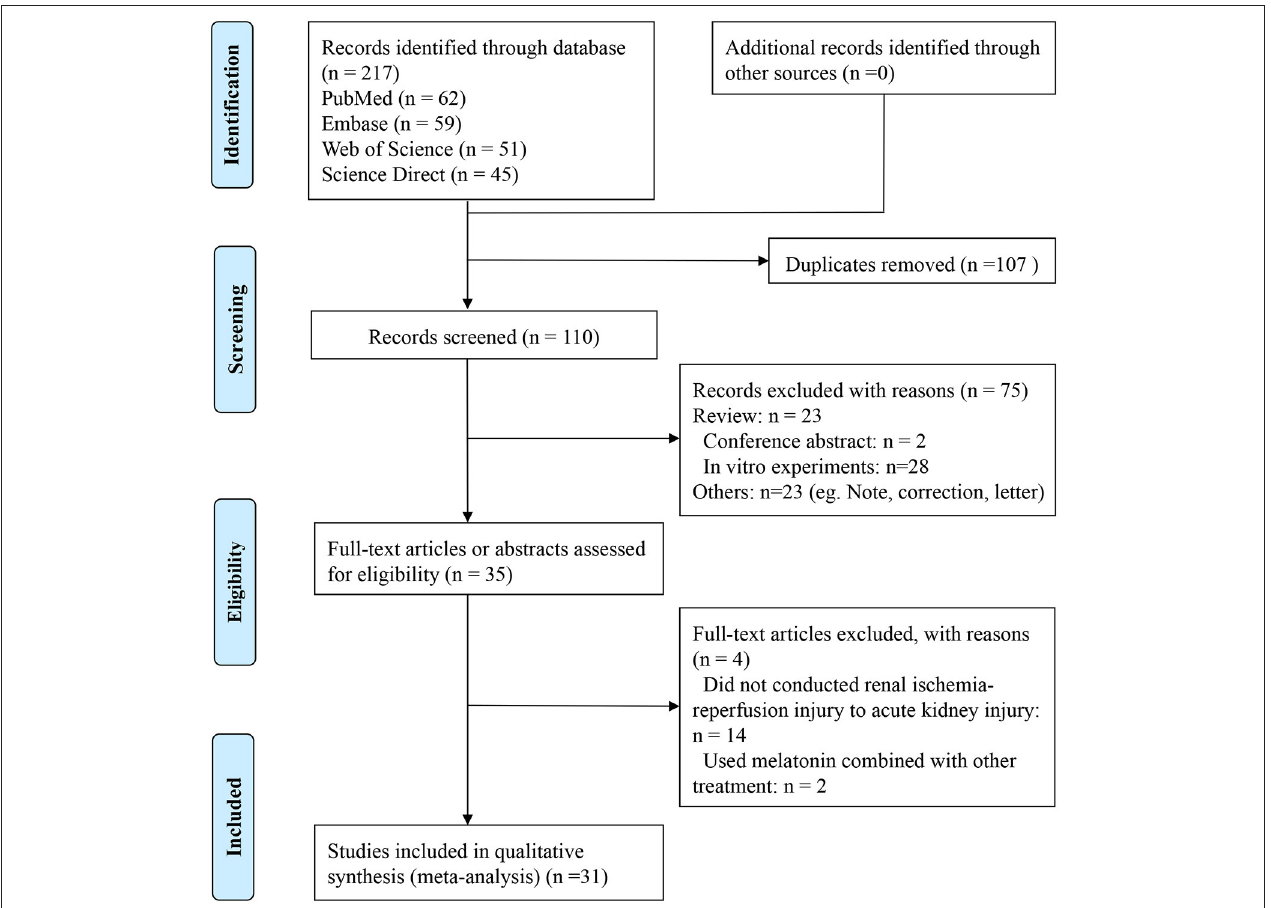
FIGURE 1 | Summary of the literature identification and selection